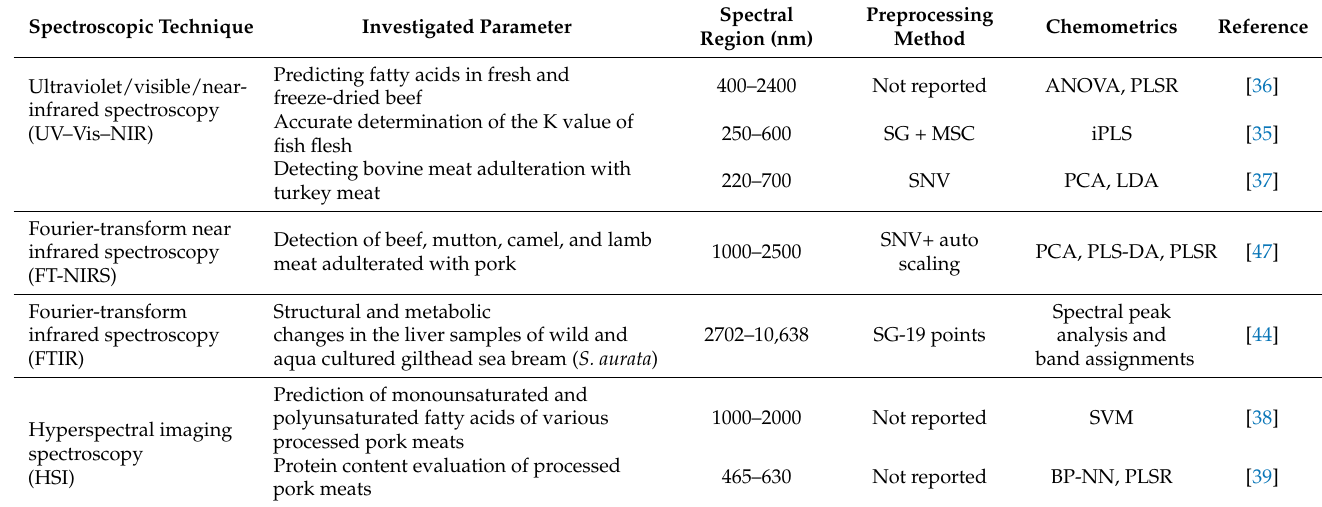
Table 3. Overview of molecular spectroscopic techniques for quality determination in meat and